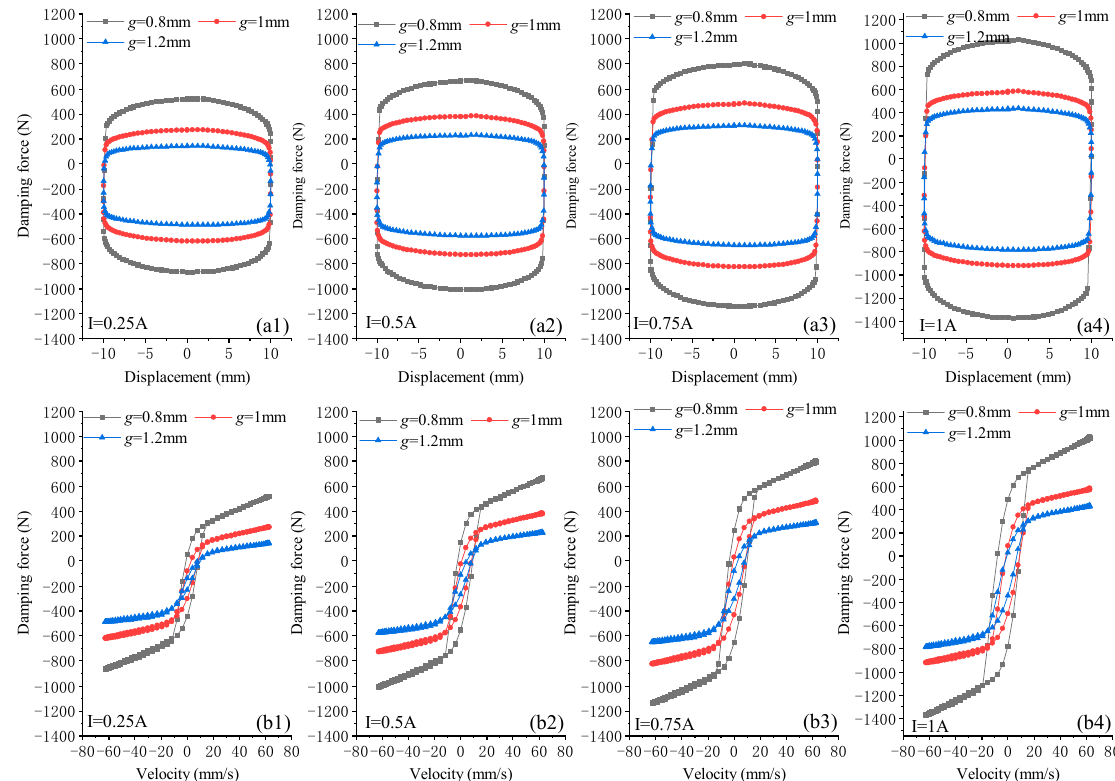
Figure 11. Damping characteristics at different damping gaps for I = 0.25, 0.5, 0.75 and 1 A: ( a1 – a4 ) damping force–displacement; and ( b1 – b4 ) damping force–velocity.